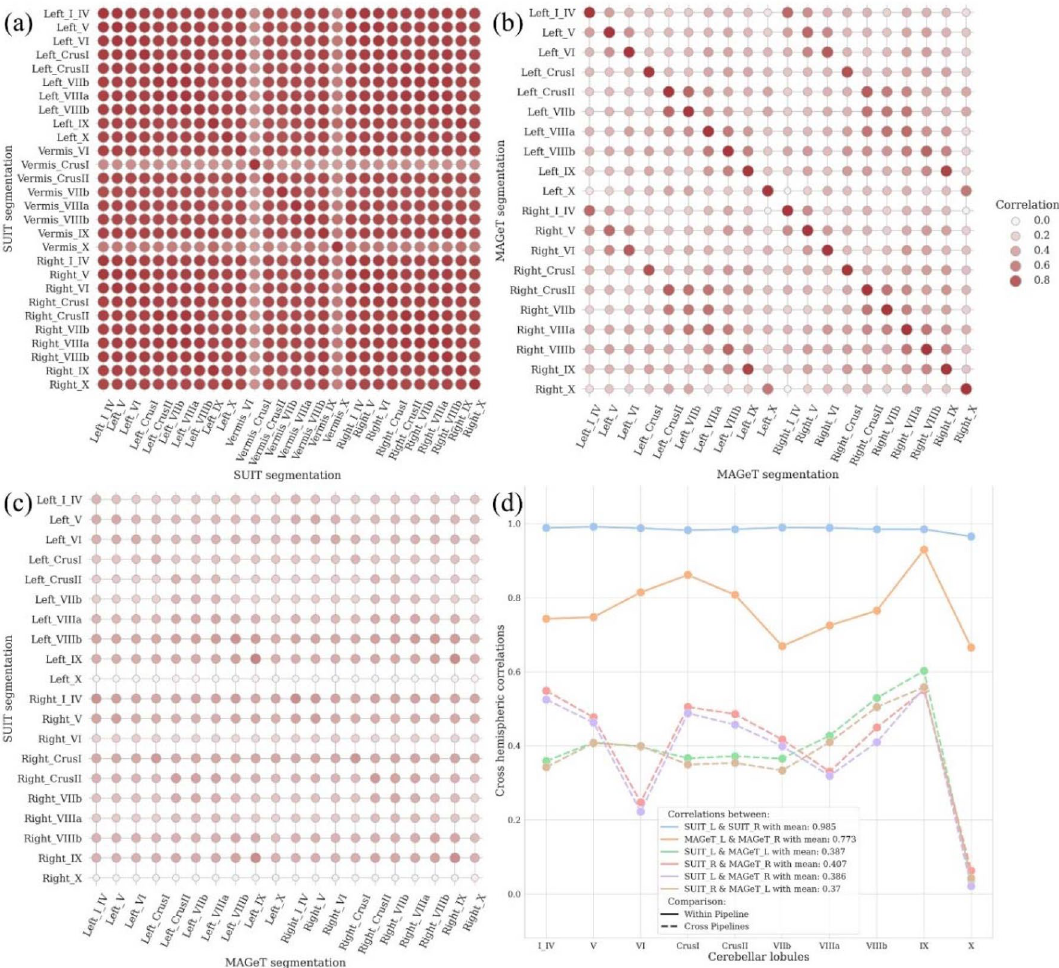
Figure 3. Cerebellum segmentation results from SUIT and MAGeT. ( a ) Correlation of SUIT cerebellar lobular volumes. ( b ) Correlation of MAGeT cerebellar lobular volumes. ( c ) Correlation between SUIT and MAGeT hemispheric cerebellar lobular volumes. ( d ) Correlation of cross hemispheric lobular volumes within and between SUIT and